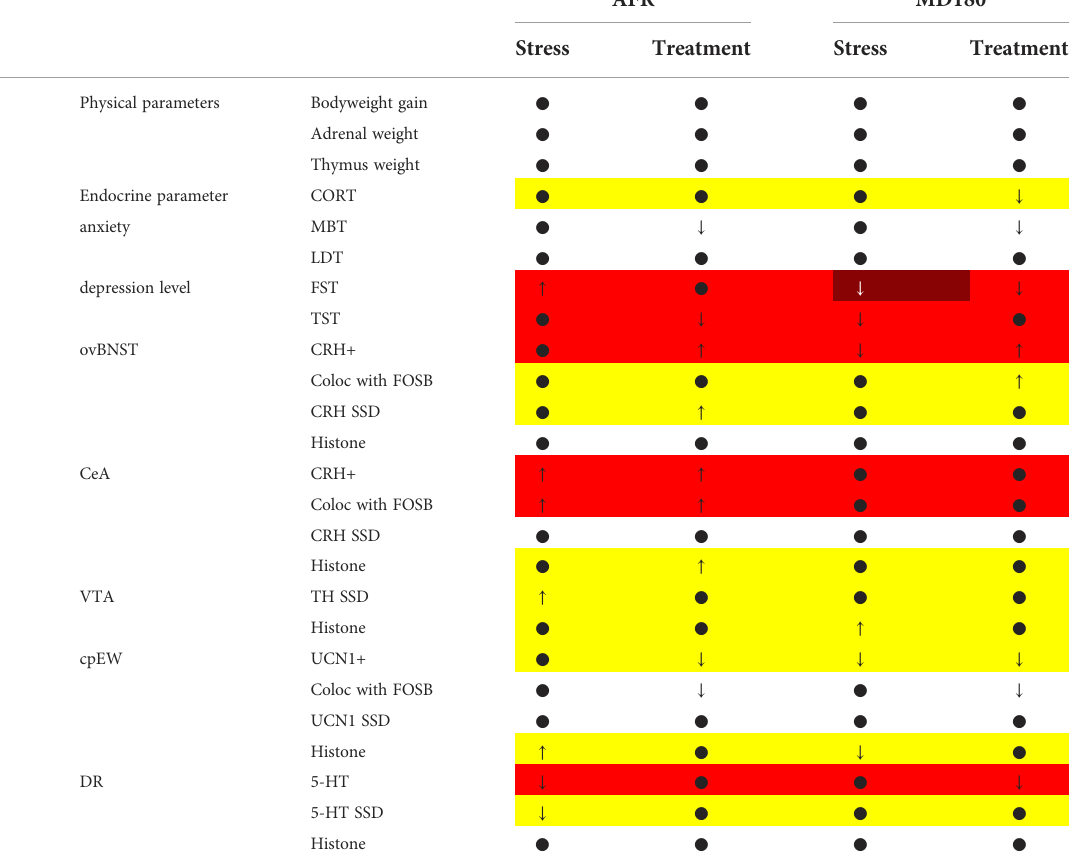
TABLE 1 Summary of maternal deprivation effects on stress and treatment.